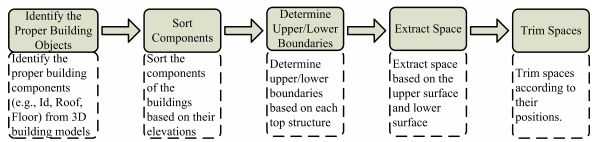
Figure 2. The workflow of the space